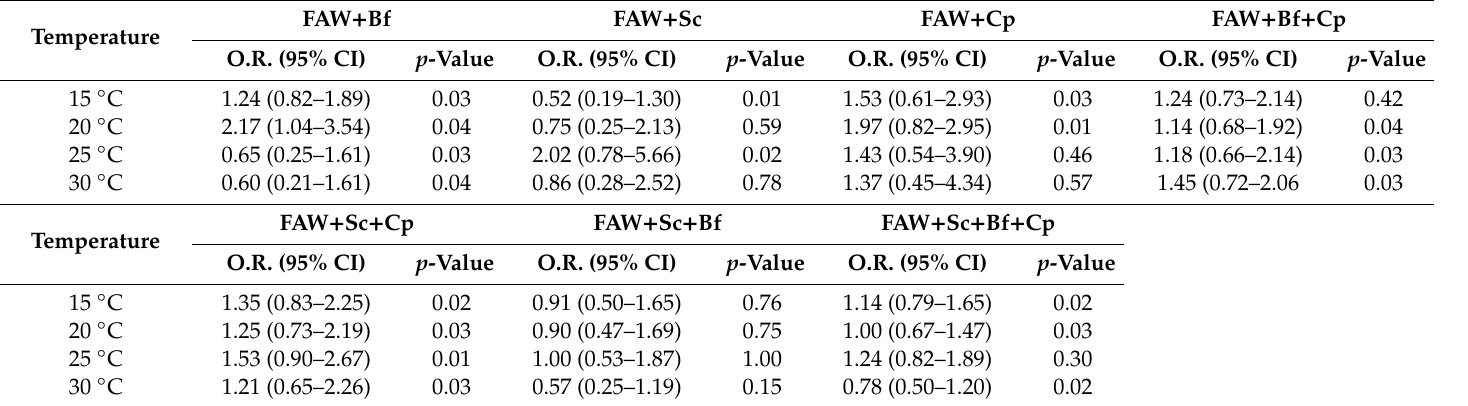
Table 3. Results of GLM analysis comparing larval survival between fall armyworm vs. stemborer species in multi-species combinations at di ff erent constant